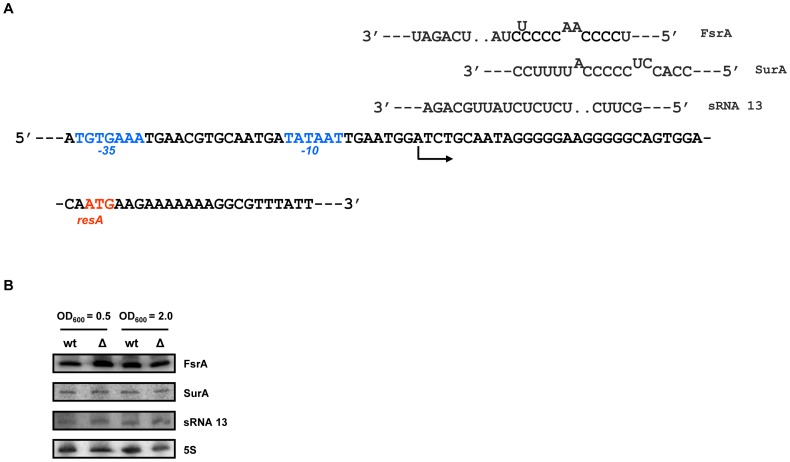
The abundance of putative sRNA regulators of resA is independent of Hfq.(A) Partial sequence of the 5′-untranslated region of resA and of the initial coding region. The −10 and −35 regions of the resA operon promoter are highlighted in blue. Arrow: start site and direction of transcription. The start codon (ATG) of resA is indicated in red. Predicted base-pairing interactions of sequences of FsrA, SurA and sRNA 13 with the rbs of resA mRNA. (B) The levels of FsrA, SurA, sRNA 13 and 5S rRNA (loading control) were determined by Northern-blot analyses as described in Materials and Methods. Bacillus subtilis strains 168 wt (wt) and 168Δhfq (Δ) were grown in CS-glucose medium at 37°C. Samples for RNA extraction were withdrawn at the OD600 values indicated on top. Only the relevant sections of the autoradiographs are shown.